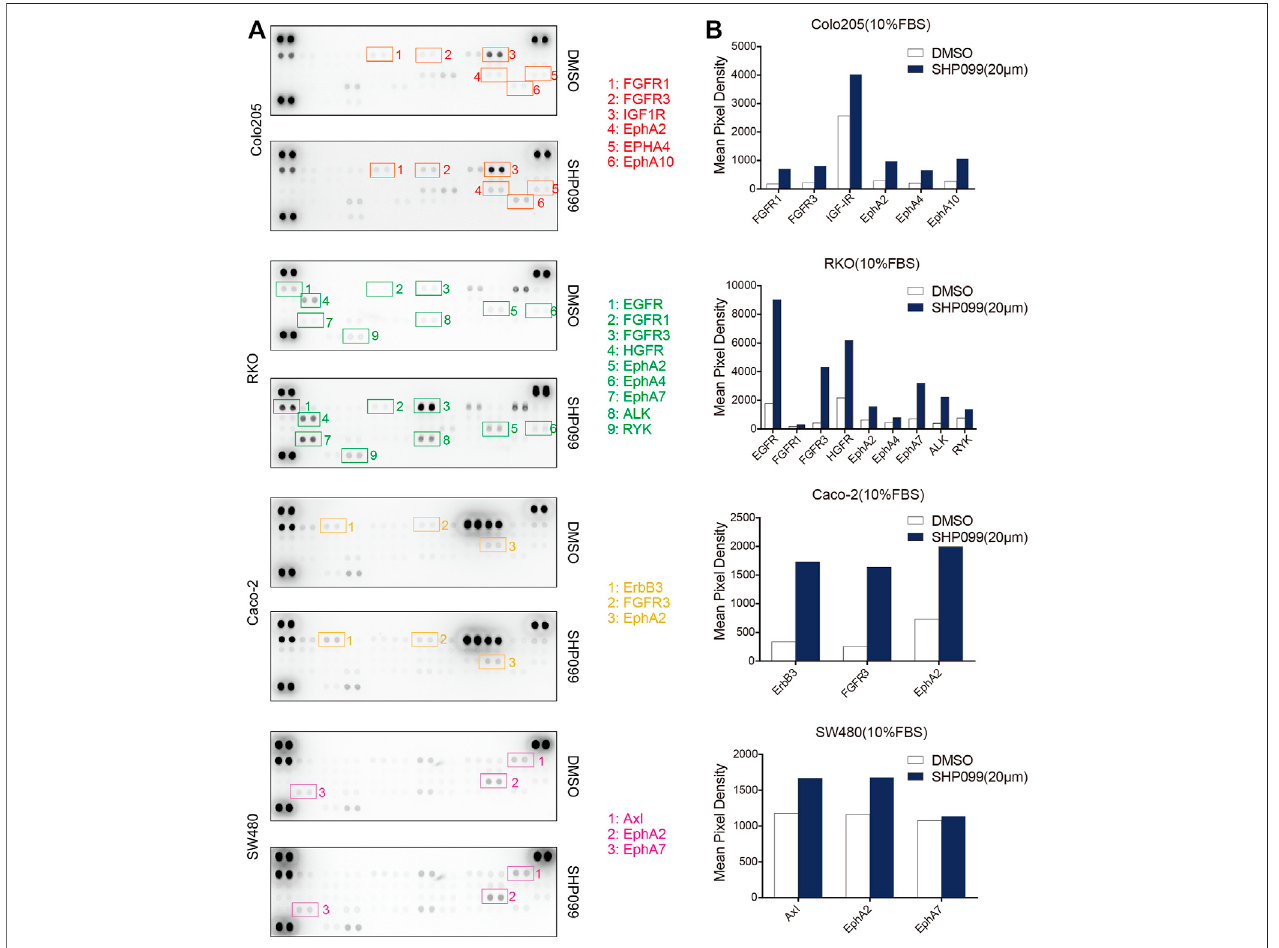
FIGURE5| SHP2inhibitionwithSHP099inducesseveralphosphorylatedRTKs. (A) Inducedexpressionpro fi lesofRTKsbySHP099for24 hinCRCcellswiththe examination by phospho-RTK arrays. Spots are in duplicate, and each pair corresponds to a speci fi c p-RTK. (B) Comparison of typical induced p-RTK expression by SHP099 across several CRC cell